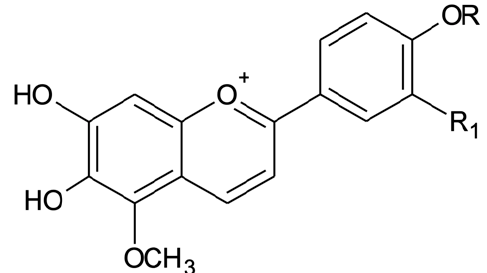
Figure 1. Chemical structures of the anthocyanidins described for Arrabidaea chica : ( 1 ) 3 ′ -hydroxy-carajurone (R 1 = OH, R = H); ( 2 ) carajurone (R 1 = H, R = H); ( 3 ) 3 ′ -hydroxy-carajurin (R 1 = OH, R = CH 3 ) and ( 4 ) carajurin (R 1 = H, R = CH 3 ).